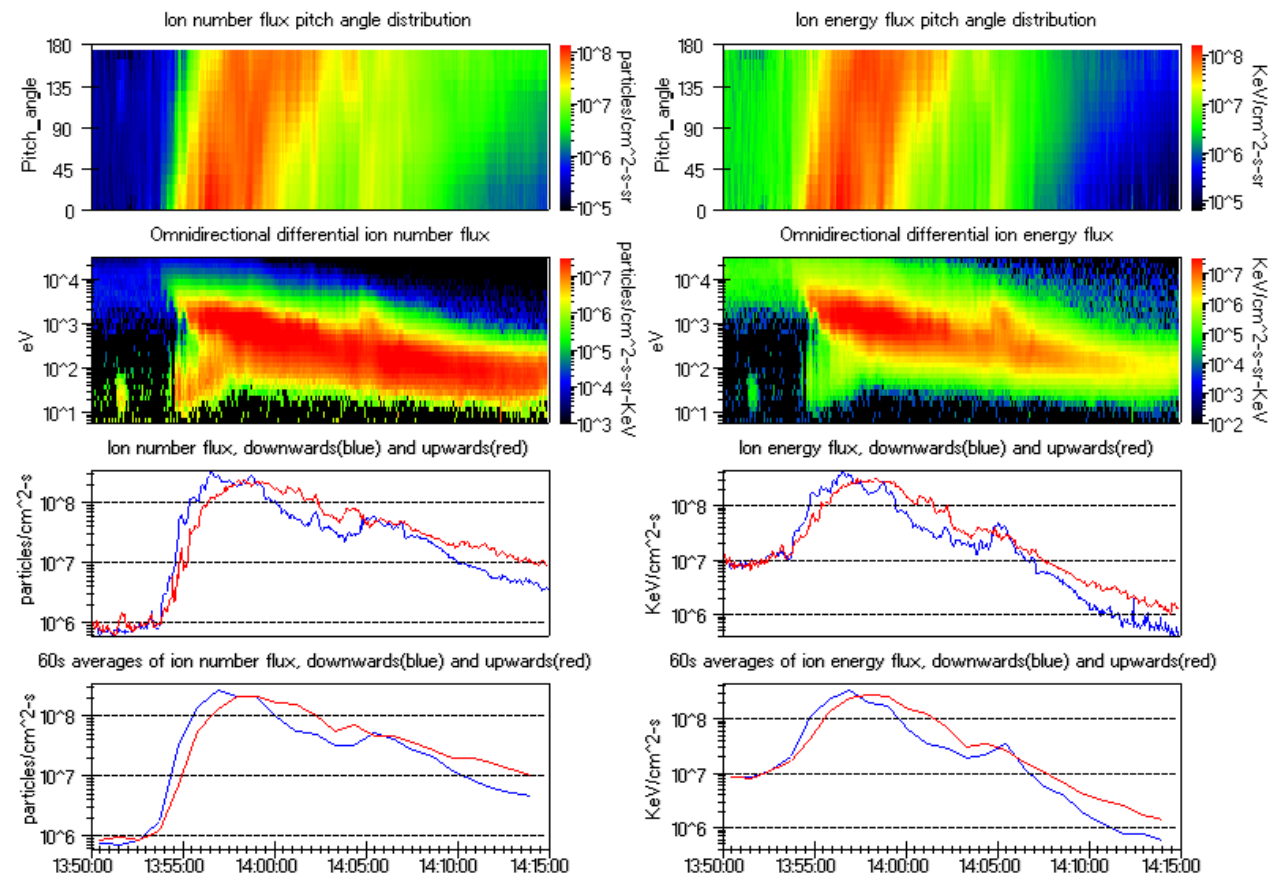
Fig. 2. Pitch angle distribution, omnidirectional flux, downward/upward fluxes and 60s averaged downward/upward fluxes, for number flux in the left column and energy flux in the right column. For the data in this figure, a pitch angle of 0 is downwards and a pitch angle of 180 is